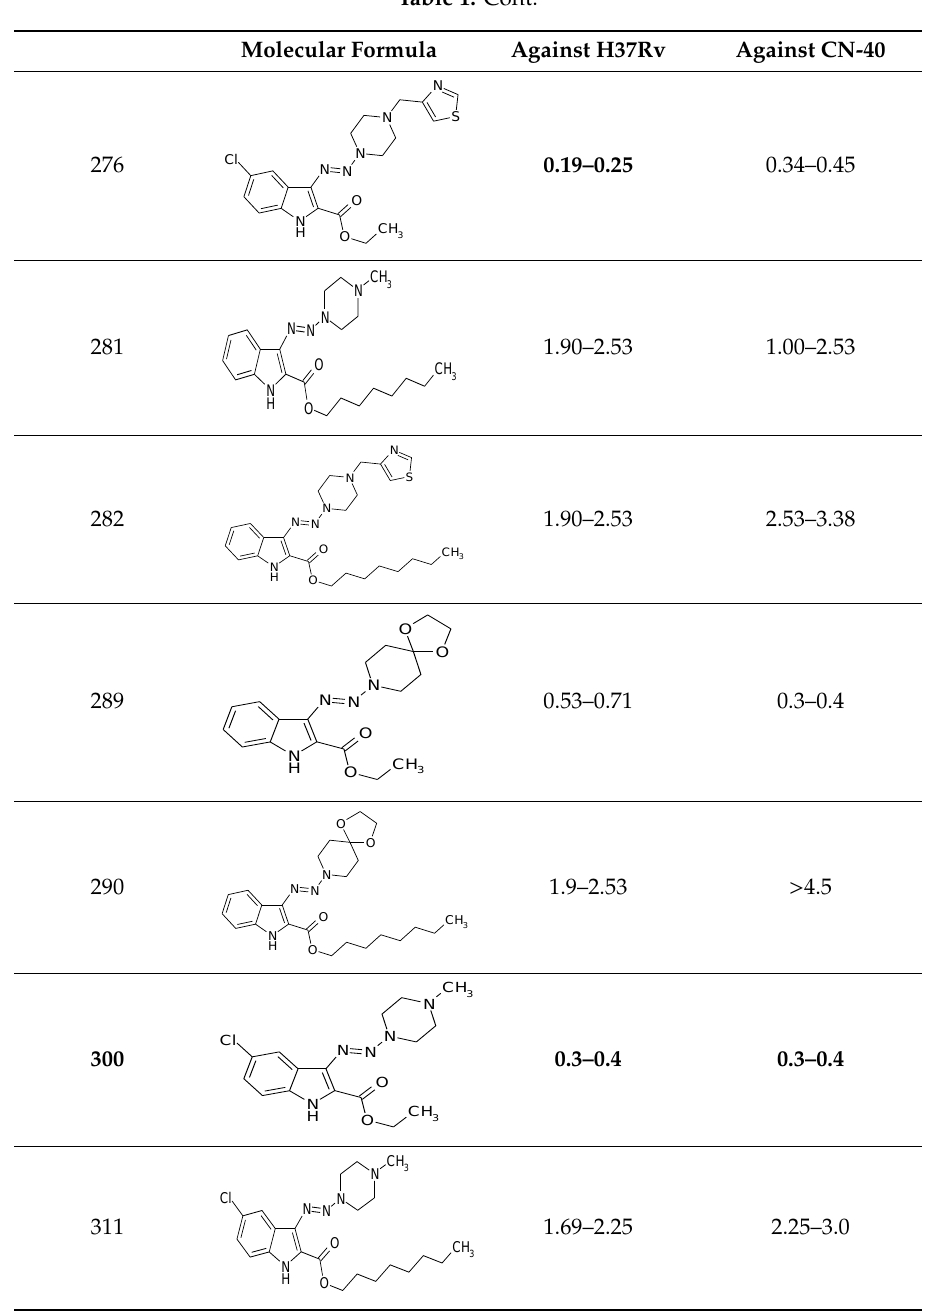
Table 2. Introduction of octyl residues improves performance of 3-triazeneindoles against intracellular M. tuberculosis.